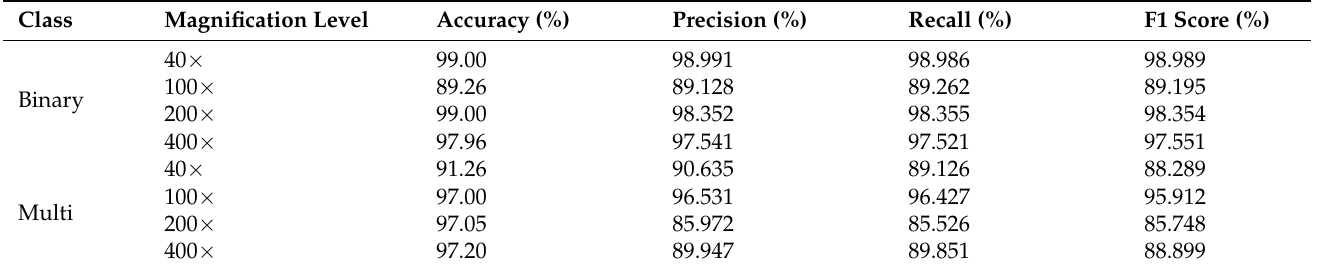
Table 6. Detailed classification results of FabNet on BreakHis dataset based at different magnification